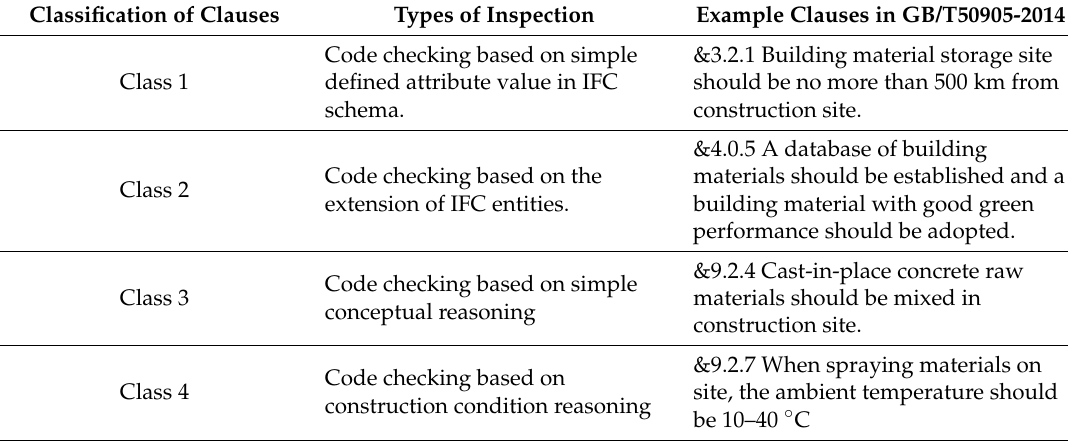
Table 1. Classification of various kinds of clauses in